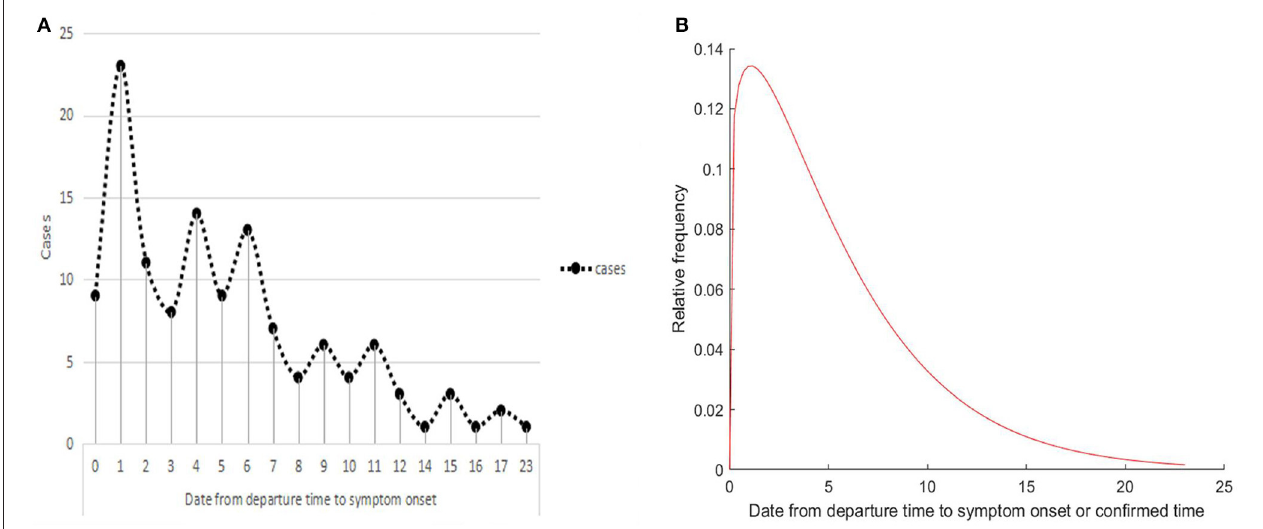
FIGURE 3 | The incubation period of COVID-19. (A) Frequency distribution of incubation periods. (B) Estimation of incubation period by fitting a Weibull distribution.